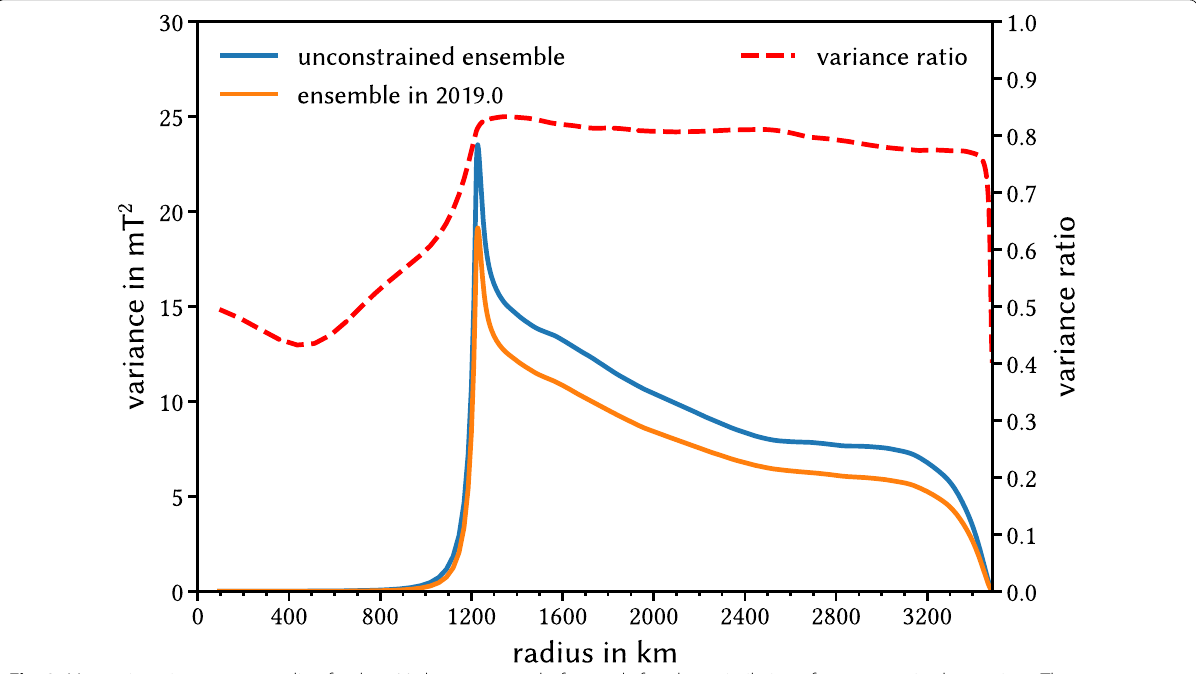
Fig. 3 Magnetic variance versus radius, for the 100 dynamo states before and after the assimilation of geomagnetic observations. The unconstrained ensemble refers to 100 decorrelated independent dynamo states extracted from a 70,000-year-long free run integration of the coupled Earth Dynamo. The ensemble in 2019.0 is obtained after applying a Kalman filter to adjust the magnetic field in the core interior for each ensemble member, given the constraints provided by the initial field model constructed at epoch 2019.0 from one year of Swarm data. The variance ratio is the ratio of the variances of the adjusted ensemble to the unconstrained